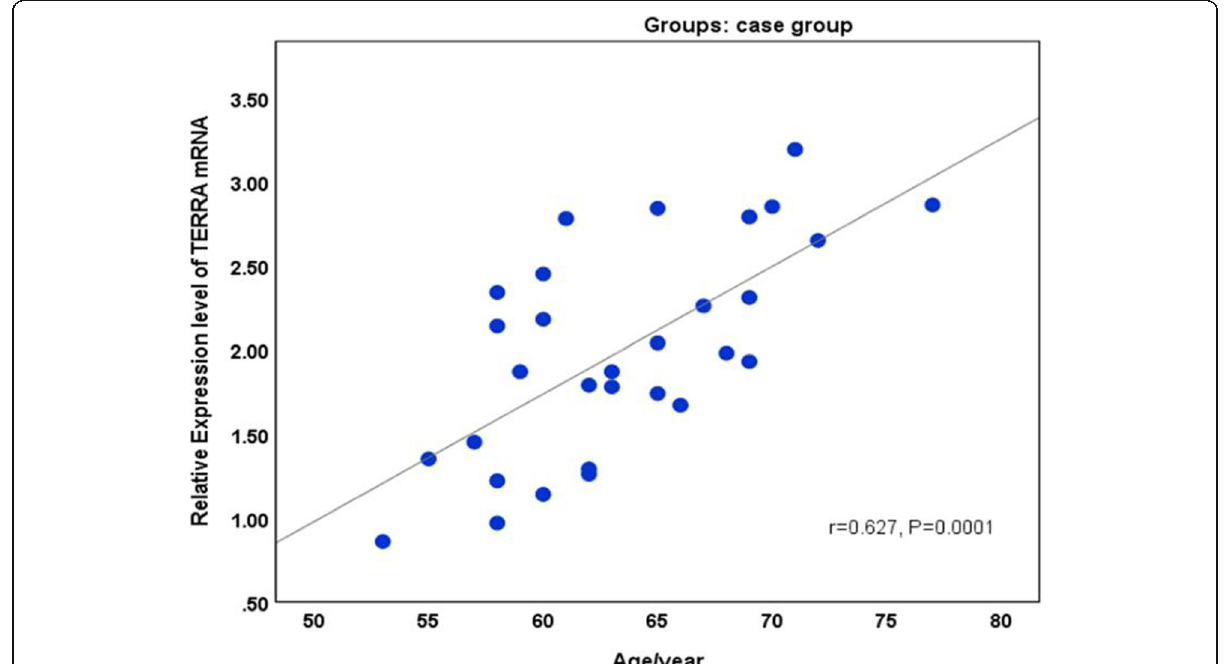
Fig. 3 Scatter diagram showing that both relative expression and age have a positive